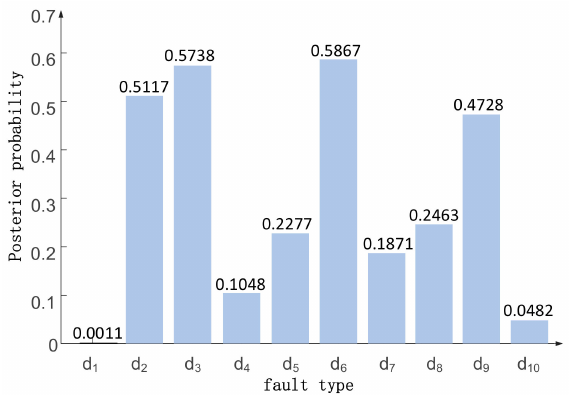
Figure 4. Probability distribution diagram of fault